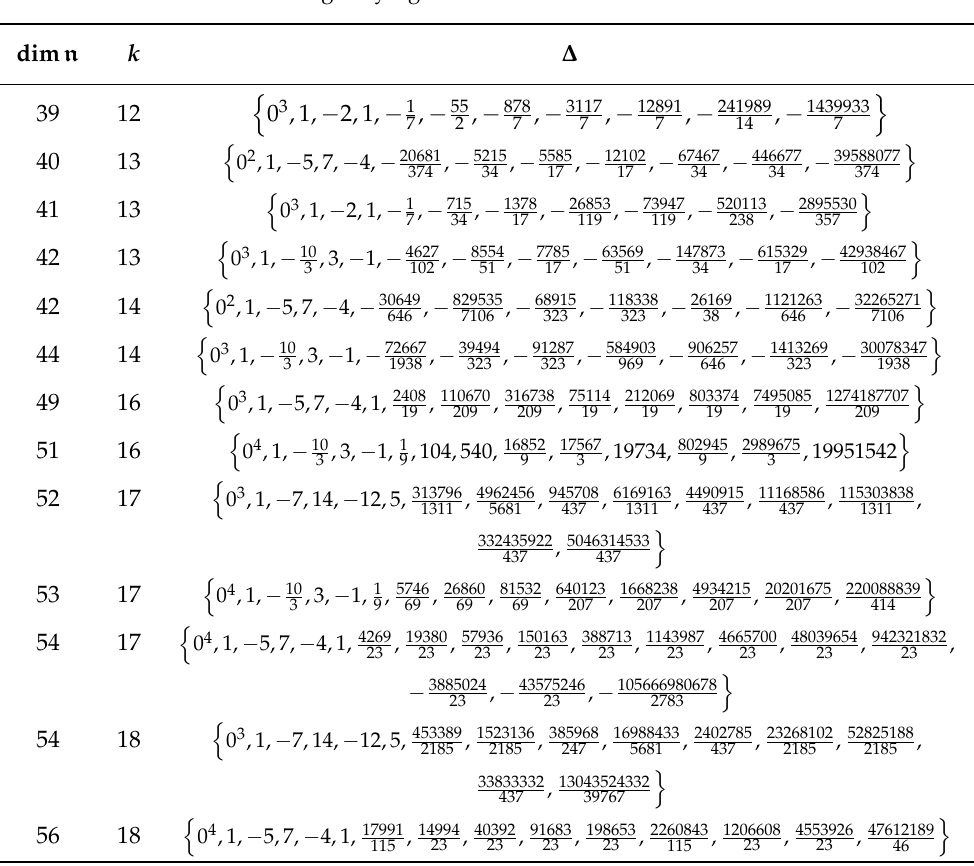
Table 6. Other isolated cohomologically rigid